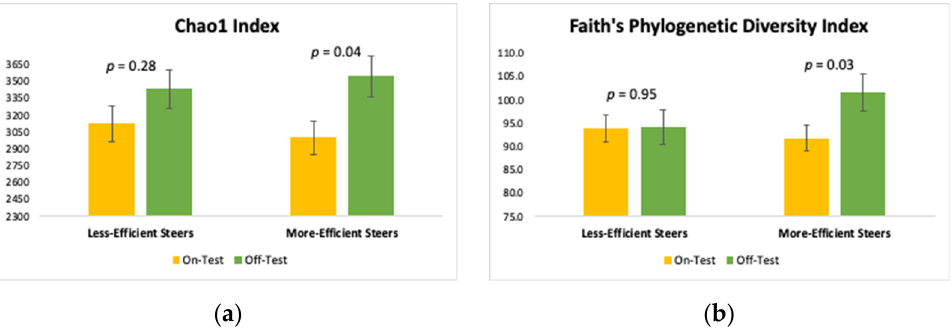
Figure 1. Chao1 index (microbial richness estimator) ( a ) and Faith’s Phylogenetic Diversity Index (microbial diversity estimator) ( b ) calculated for the less efficient (High RFI) and more efficient (Low RFI) steers at the beginning (d 0) and end (d 82) of the feedlot phase.